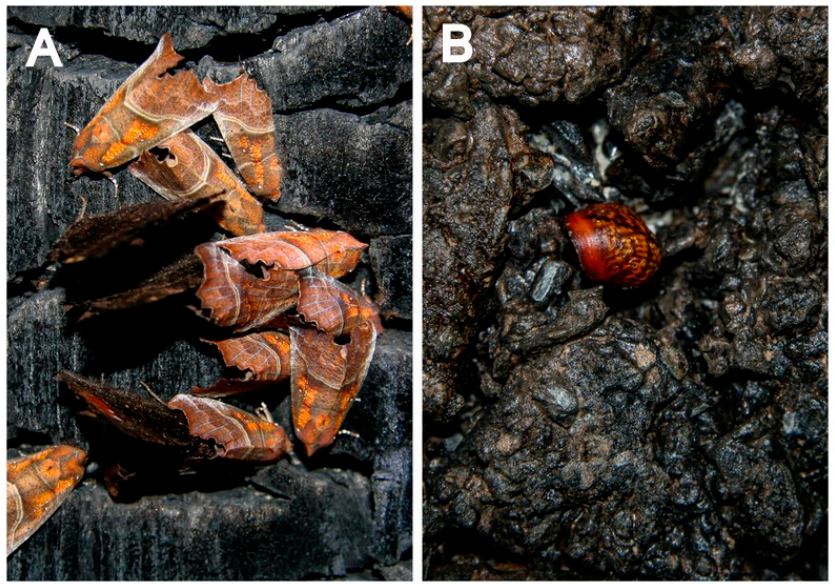
Figure A5. ( A ): A group of haralds ( Scoliopteryx libatrix ) on the walls of a bunker that was burned during World War II. We can observe orange drawings on the enclosed wings that resemble the letter ‘M’ (SA-CEF number 27). ( B ): Land snail Monachoides incarnatus hidden in a wall gap (SA-CEF number